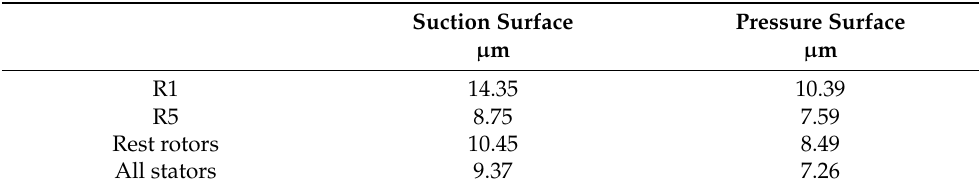
Table 2. Equivalent gravel roughness of suction and pressure surfaces at all